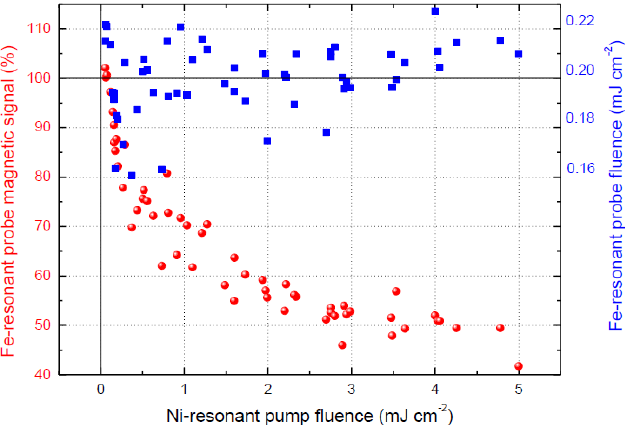
Figure 8. Ni-3p pump/Fe-3p probe resonant magnetic scattering in NiFe 2 O 4 . The Fe magnetic signal is measured 530 fs after the pump pulse as a function of the pump fluence (red circles, left axis). The Fe-resonant probe fluence (blue squares, right axis) is unaffected over the spanned range of pump fluence.